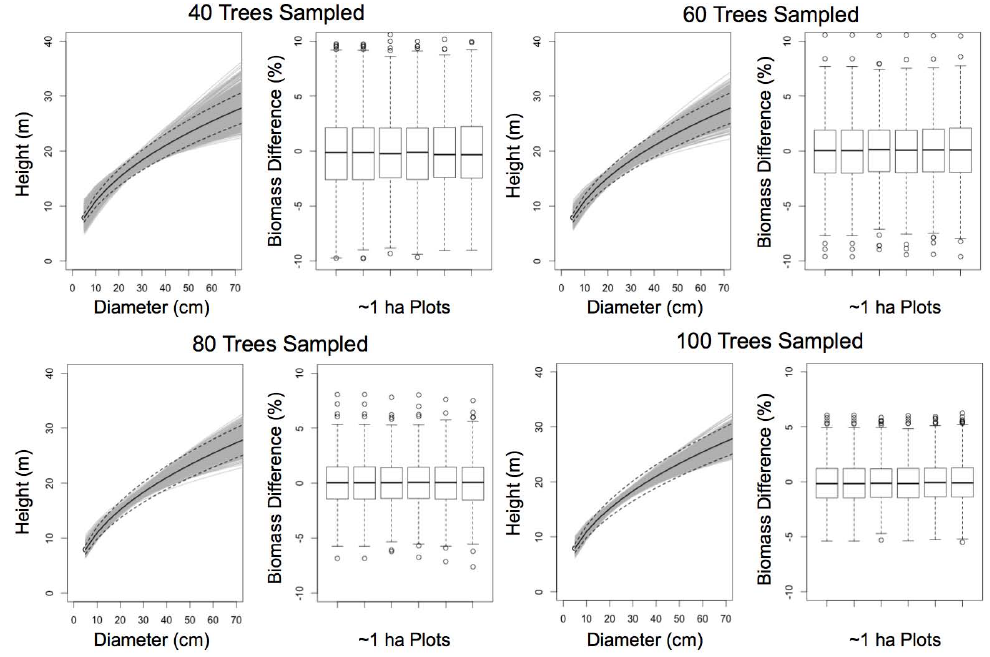
Fig. 5. Effect of sample size on the resulting diameter-to-height allometric equation for Tanguro. Dashed lines represent a range of 10% difference in height. The grey area represents the range of bootstrap estimates. Boxplots show the variability in six 1ha transect biomass estimates due to differences in the predicted tree height based on sample sizes of 40, 60, 80 and 100